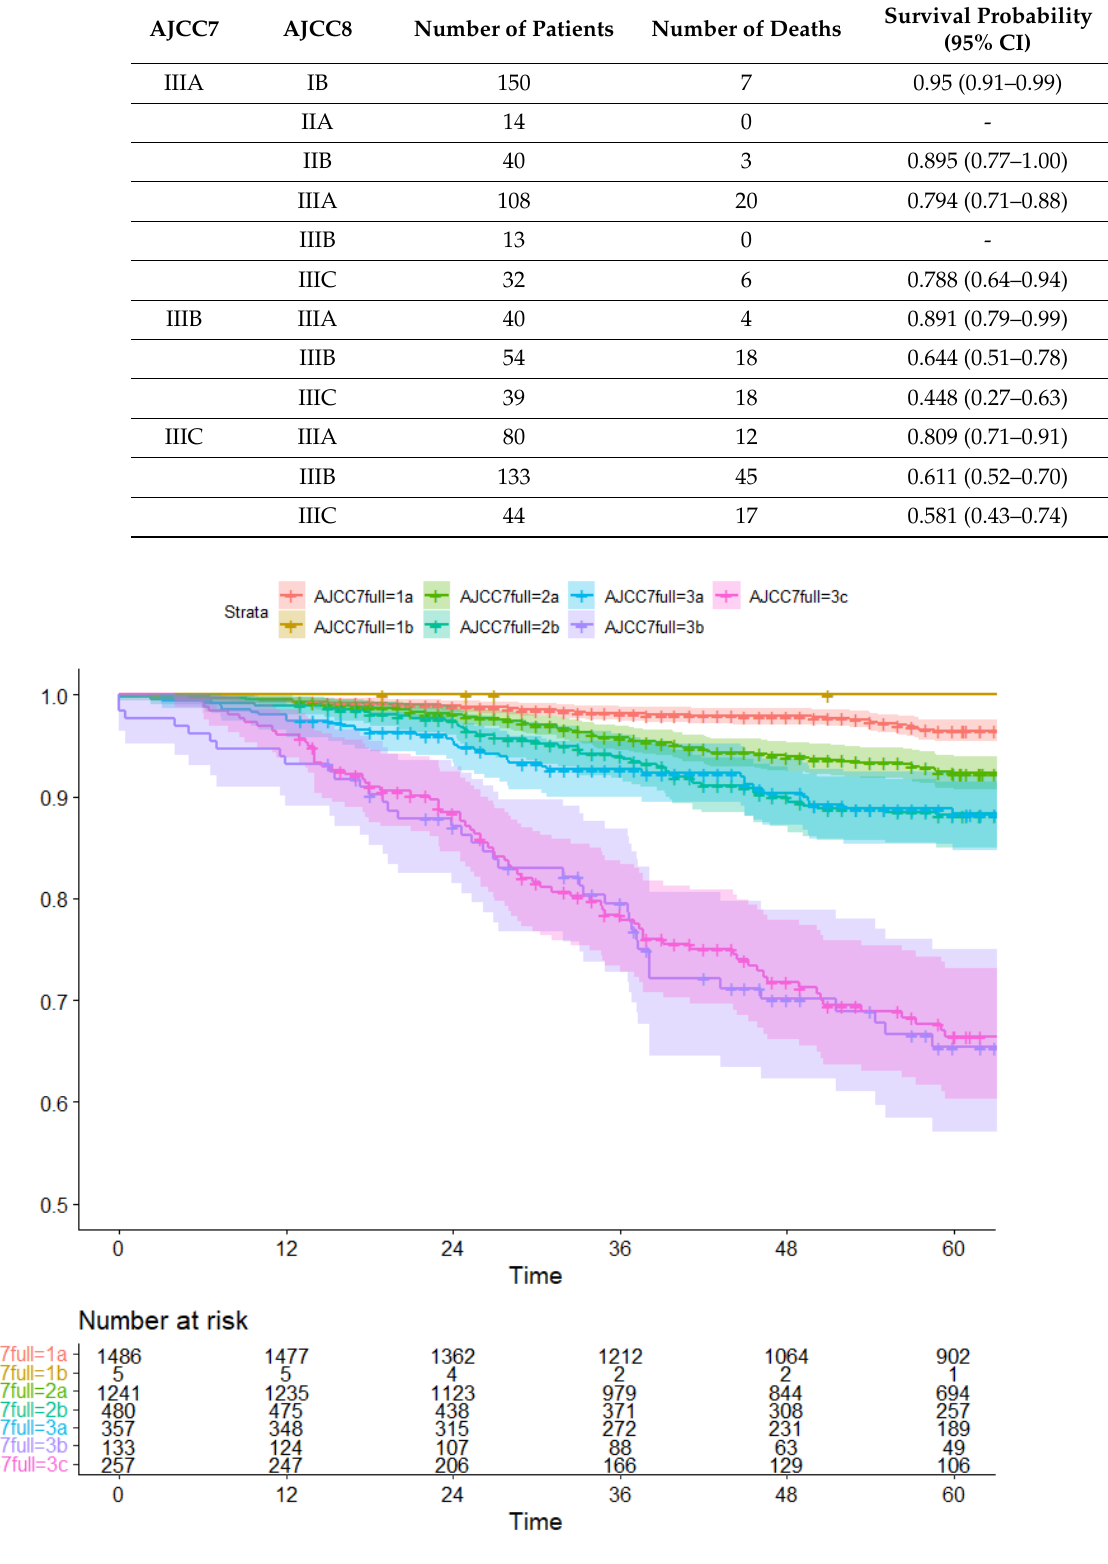
Figure 3. Kaplan Meier survival curve for overall survival (deaths from any cause) by AJCC7 stage (time in months).